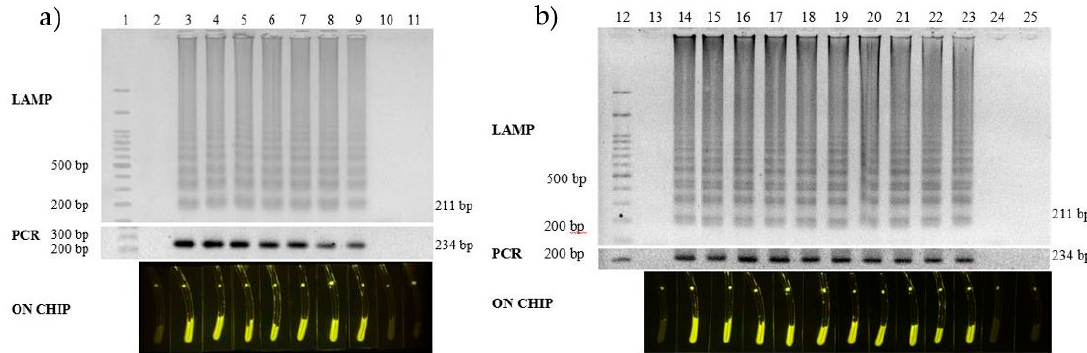
Figure 4. ( a ) The detection limit of the LAMP reaction using DNA as the template compared with that of the PCR and the on-chip assay; Lane 1, 100 base pair ladder; Lane 2, non-template control; Lanes 3–11, 10-fold serial dilutions of L. monocytogenes template DNA, ranging from 10 7 copies to 0 copies. ( b ) The detection limit by spiking the seafood sample with Listeria monocytogenes diluents with Lanes 15–19, from 10 10 CFU to 10 6 CFU; Lane 20, 1.02 × 10 5 CFU; Lane 21, 10250 CFU; Lane 22, 1033 CFU; Lane 23, 100 CFU; Lane 24, 7 CFU; and Lane 25, 0 CFU. Lane 12, 100 base pair ladder; Lane 13, non-template control; and Lane 14, L. monocytogenes plasmid.